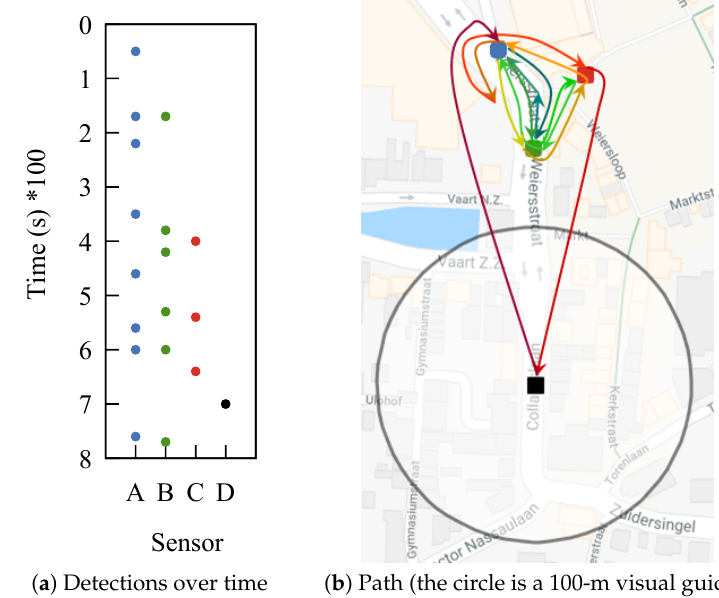
Figure 1. Irregular movements of a static device (artificial trace based on real